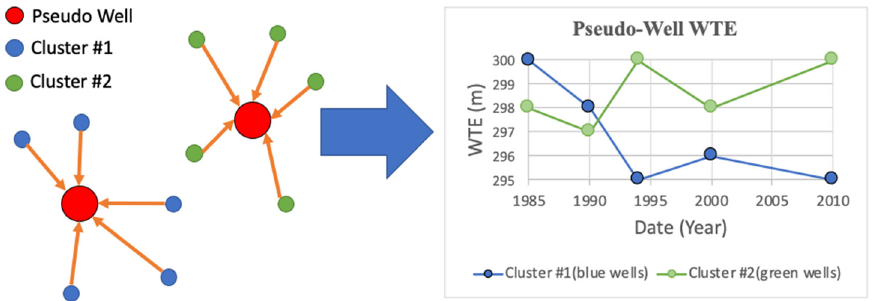
Figure 6. Creating synthetic WTE time series using the k-means-constrained clustering method.